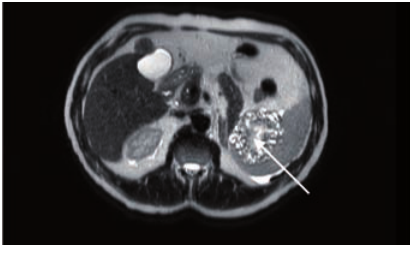
Figure 3 One year earlier a MRI scan shows a heteroge- neous, plurilocular cystic lesion of the spleen (arrow).